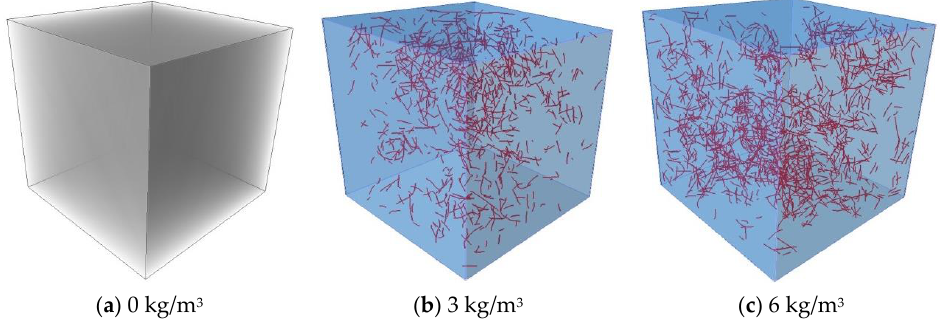
Figure 8. The model of fiber distribution.